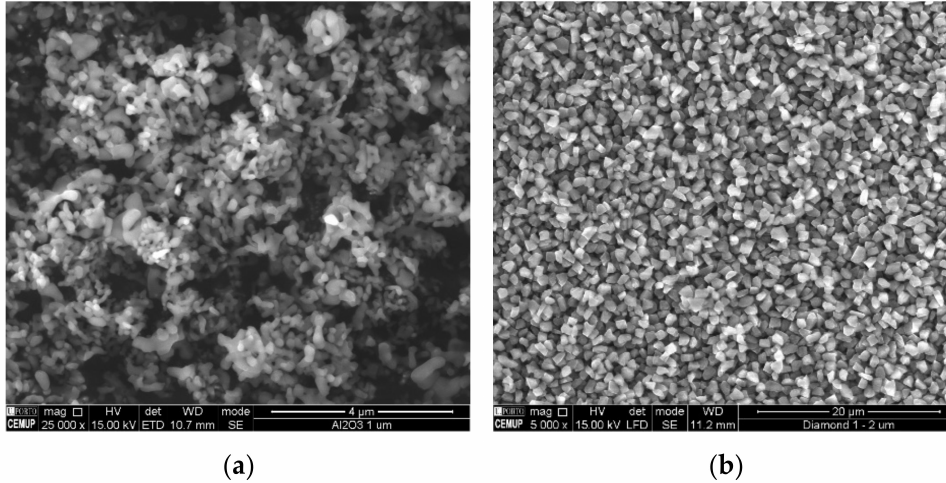
Figure 2. Morphological characterization of the abrasive particles geometry used: ( a ) alumina powder 1 µ m and ( b ) diamond powder 1–2 µ m.